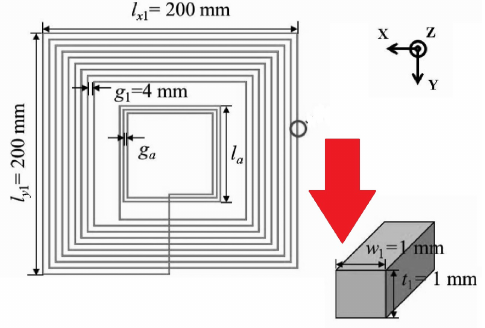
Figure 6. A WPT system with asymmetrical coil for increased coupling